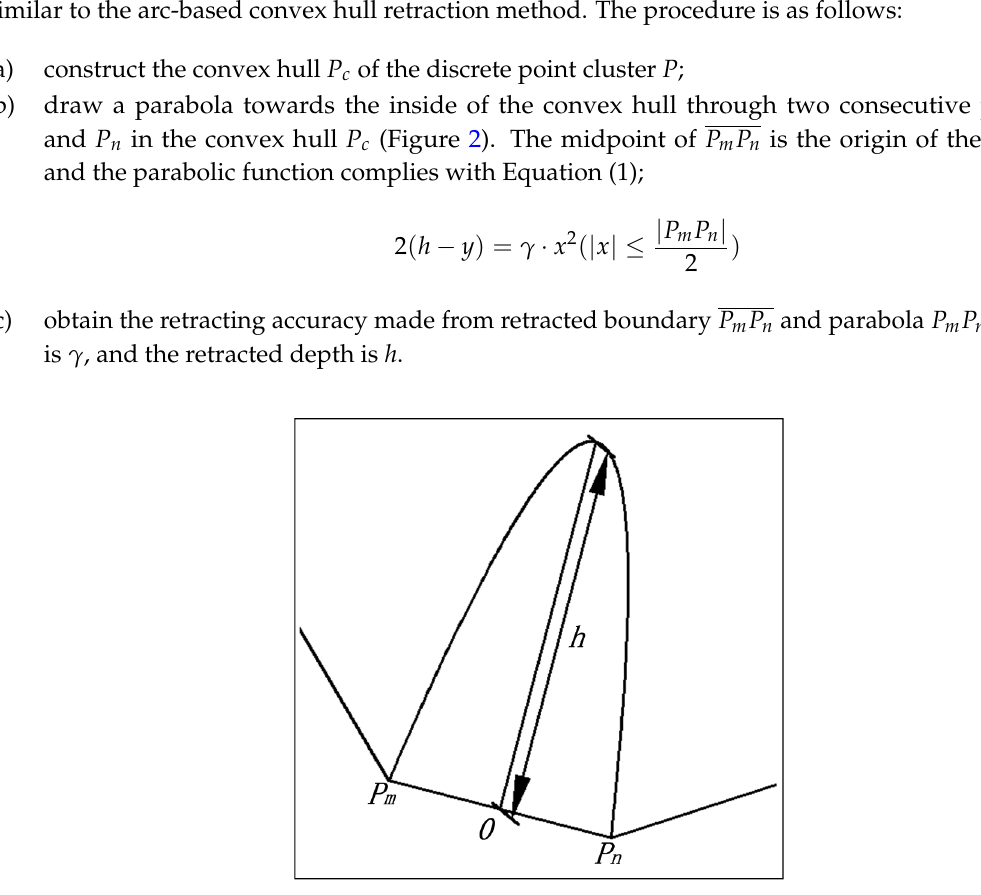
PP is one of the